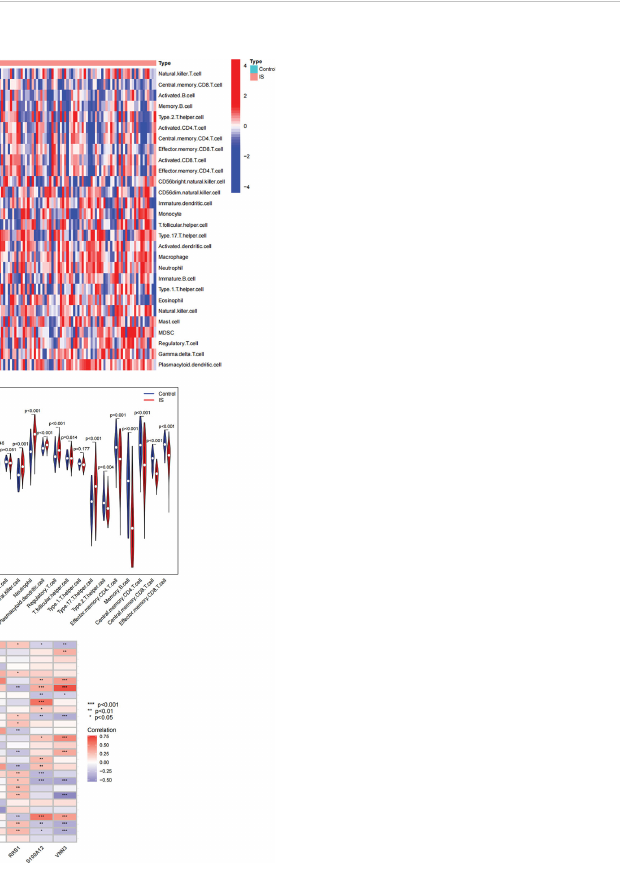
FIGURE 9 Analysis of immune cell in fi ltration associated with IS. (A, B) The distribution of 28 immune cells in IS and control samples is depicted via a heatmap and a violin plot. (C) Correlation between 6 candidate genes and immune cell in fi